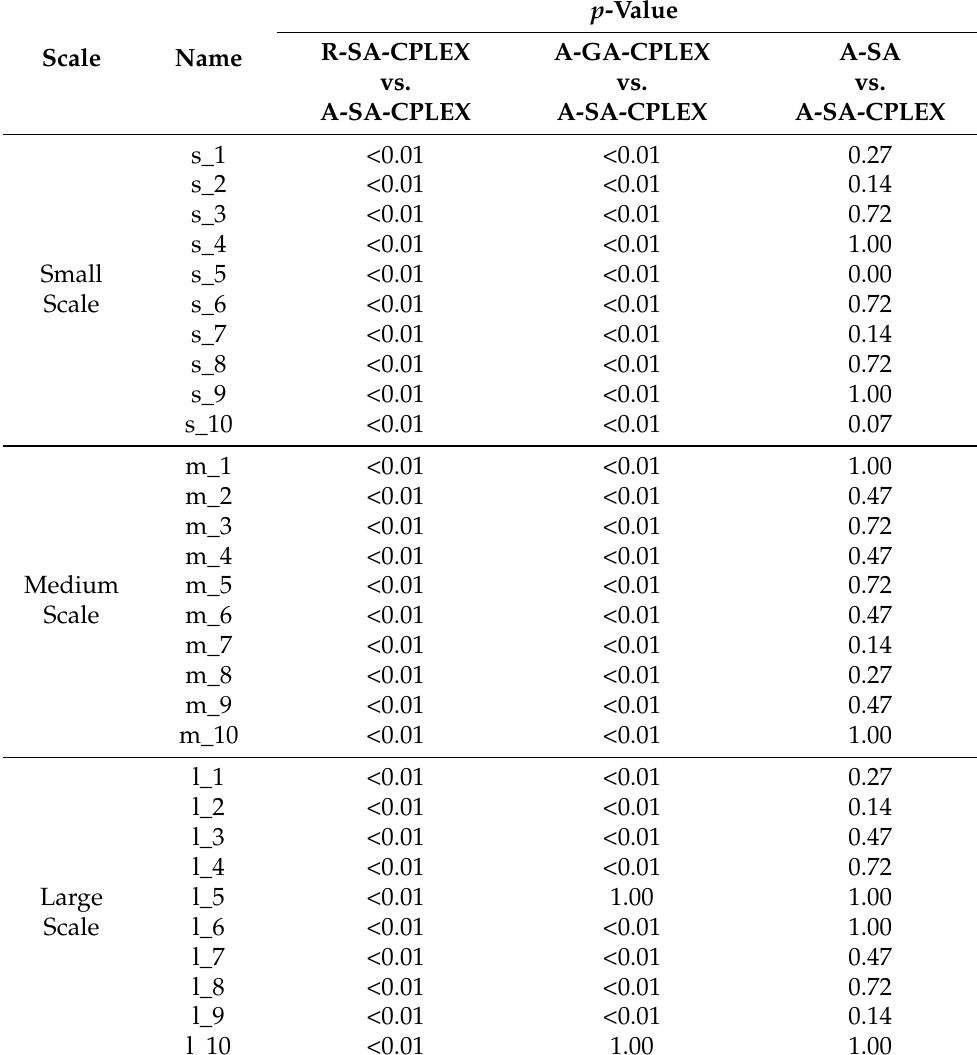
Table 3. Results from the Wilcoxon